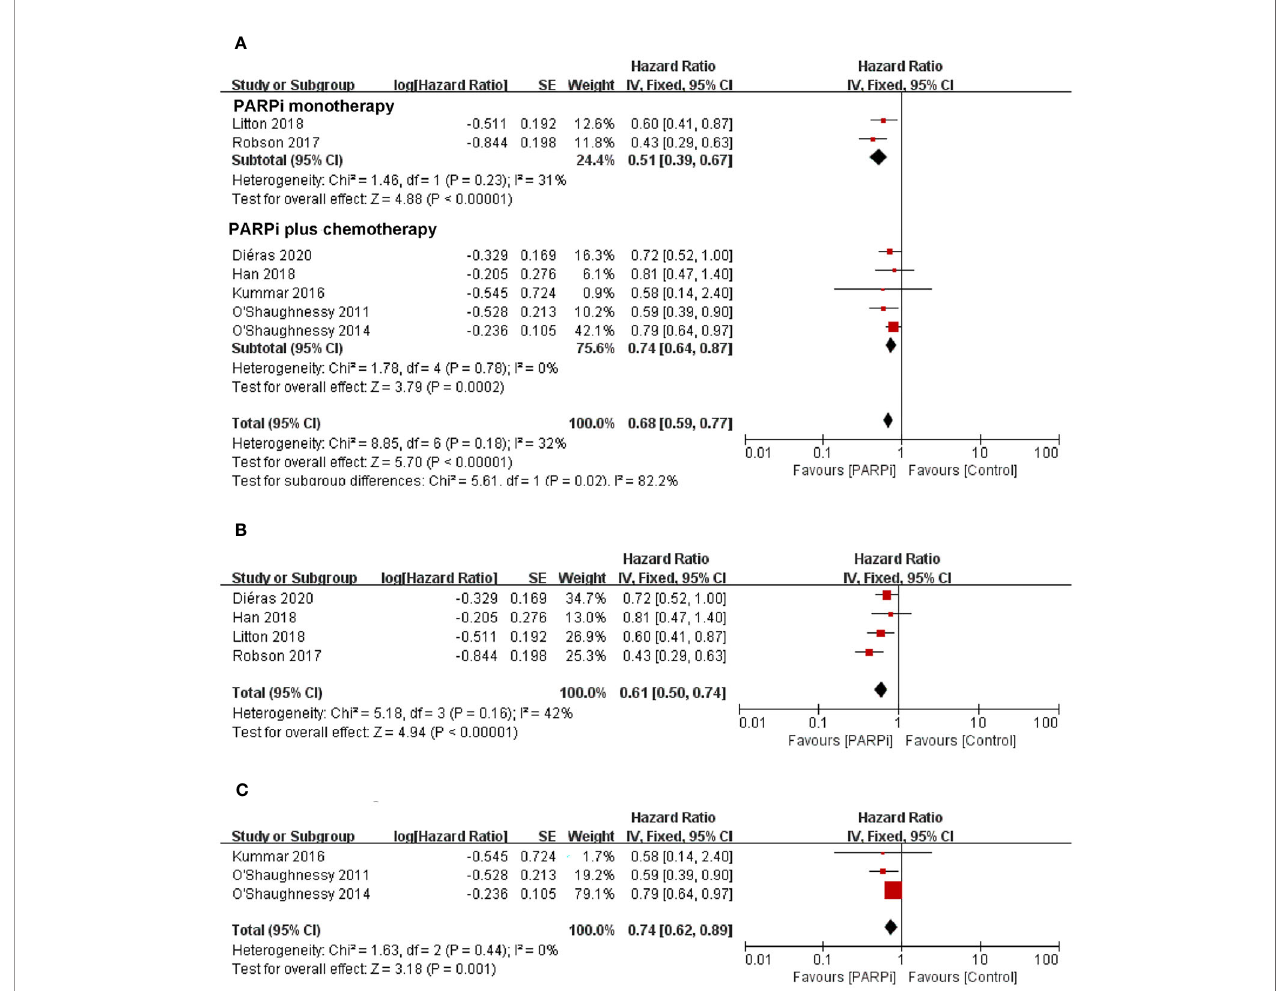
FIGURE 3 | Forest plots of pooled analyses for PARP inhibitors vs . control treatment on progression-free survival in (A) total patients, (B) BRCA -mutated patients, and (C) unselected